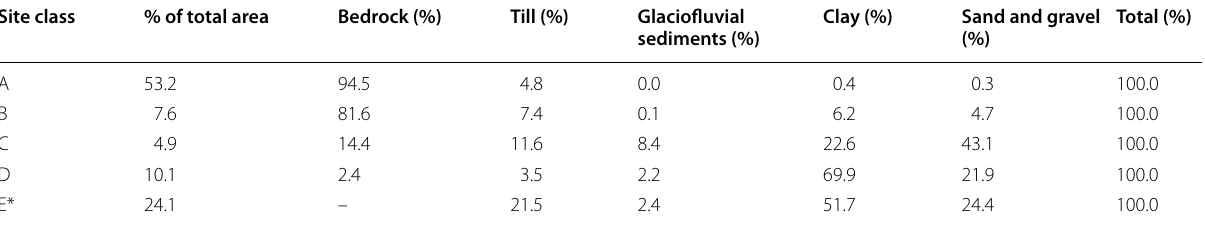
* V S,avg estimated